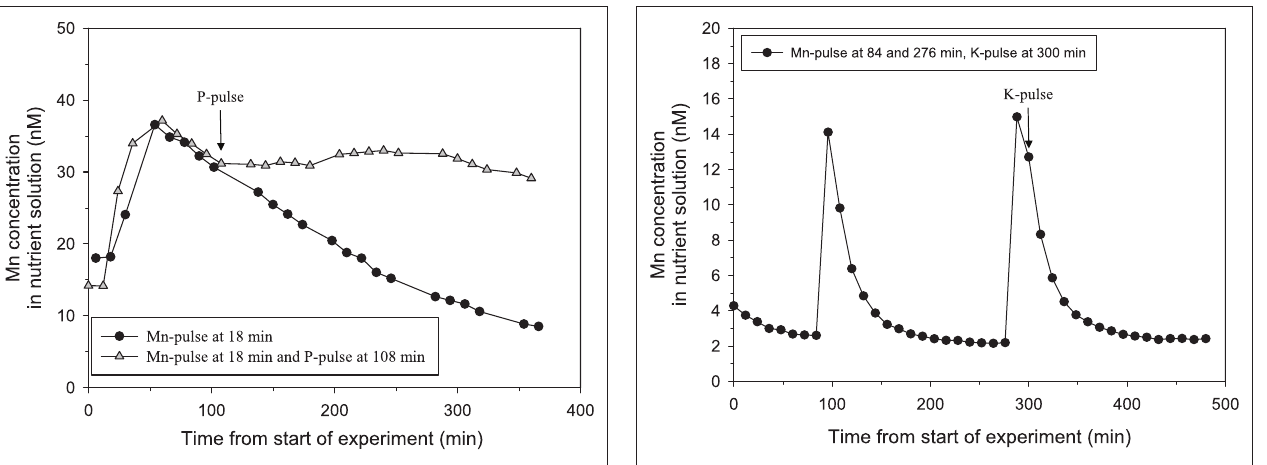
FIgure 2 | The direct effect of addition of a pulse of 500 μM P on Mn net uptake in 44-day-old plants of the Mn-efficient genotype Vanessa as